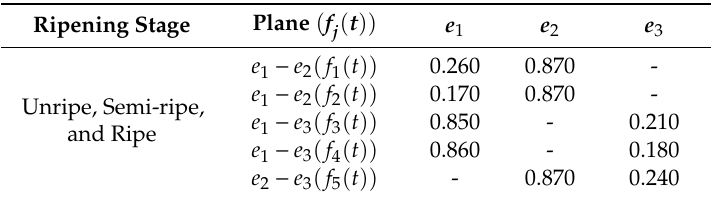
Table 4. Values of the projection γ for p 2 j and p 3 j for each f j ( t ) , ∀ j = 1, ... ,5.